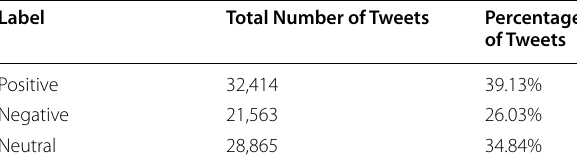
Table 7 Prediction Results of the FIFA World Cup 2018